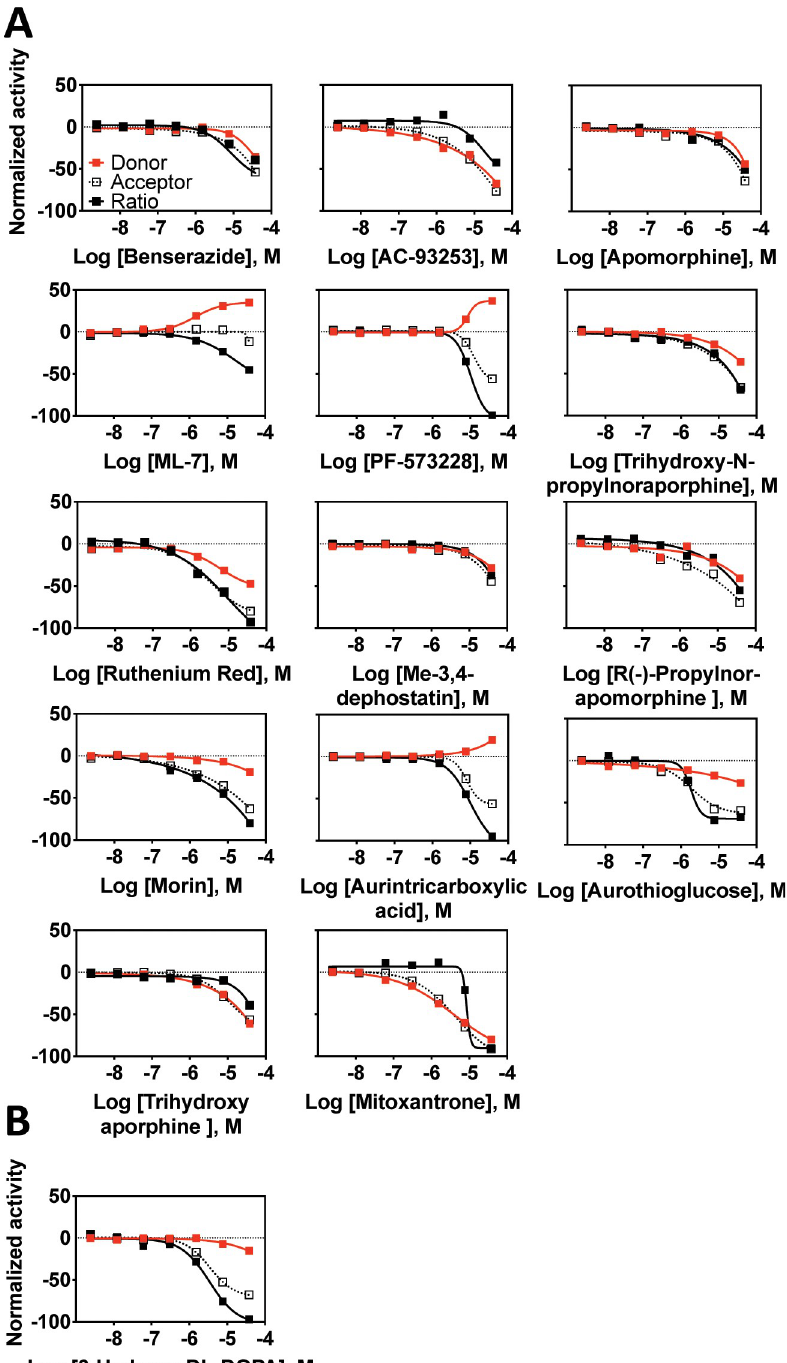
Fig 9. LOPAC active compounds from the CisBio TR-FRET assay. Normalized activity signal for the donor and acceptor channels and calculated ratio signal for each active compound reported for the 7-point concentration response generated using qHTS. Normalized activity was calculated with neutral control (+CD47 +SIRP α , no inhibitor) as 0% and low control (+CD47 -SIRP α , no inhibitor) as -100% activity. Assay activity with tested compounds was then compared and normalized within this range. (A) Compounds that interfered with donor fluorescence indicated by activity in the donor channel. (B) Reactive compound active in a variety of other unrelated screening